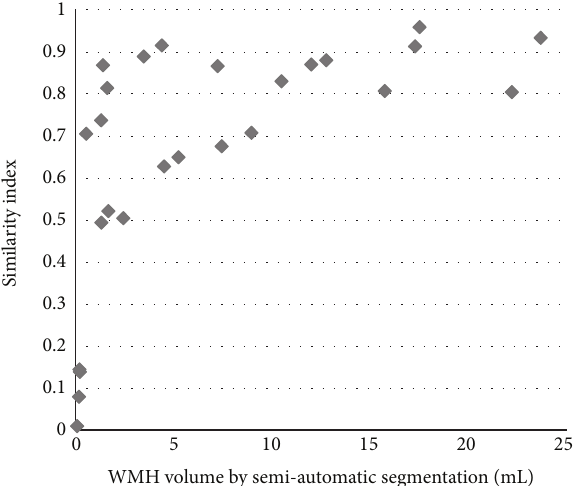
Figure 5: Similarity index for all 26 patients plotted over lesion volumes as derived from manual